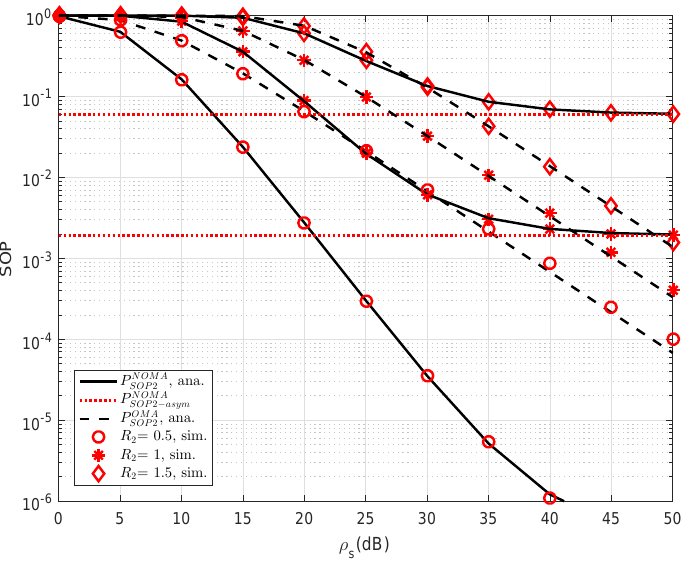
Figure 5. SOP of NOMA and OMA for User D2 versus ρ S = ρ R as varying R 2